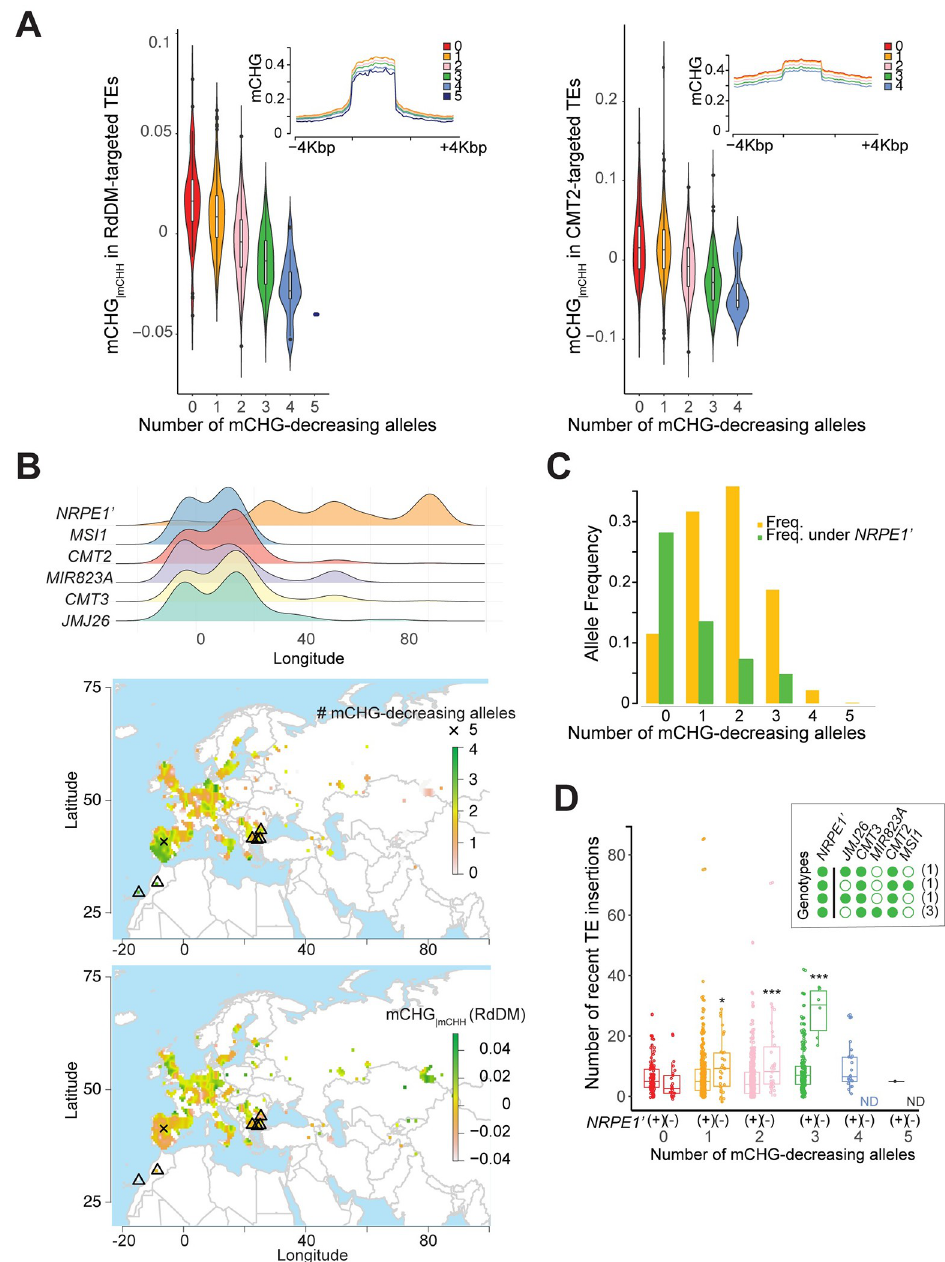
Fig 6. Cumulative effects and geographic distribution of mCHG-decreasing alleles. (A) Cumulative effect on mCHG |mCHH . Chr1:4035022 ( JMJ26 ) was excluded from the analysis of CMT2-targeted transposons as it has no effect. Chr5:2355910 was used for MSI1 . Inserted plots show mCHG levels around transposons, calculated using 20 sliding windows across the transposon body and flanking regions. (B) Longitudinal frequency distribution of mCHG- decreasing and NRPE1’ alleles (top); geographical distribution of the number of mCHG-decreasing alleles (middle), and mCHG |mCHH levels in RdDM-targeted transposons (bottom). Triangles correspond to lines in the inserted plot of panel D. (C) The frequency of distribution of the number of mCHG-decreasing alleles, separately for NRPE1’ genotypes. (D) The number of recent transposon insertions [22] as a function of NRPE1’ genotype and the number of mCHG-decreasing alleles. Significance was tested using a permutation test (see Methods; ��� is p < 0.01, � is p < 0.1). The insert shows the six observed genotypes with three mCHG-decreasing and the NRPE1’ non-reference allele. Filled circles indicate mCHH- or mCHG-decreasing alleles. Mapping and statistical testing were performed in R version 3.5.3. Maps were generated using the following packages: maps, ggridges, ggplot, rasrer, tidyverse.